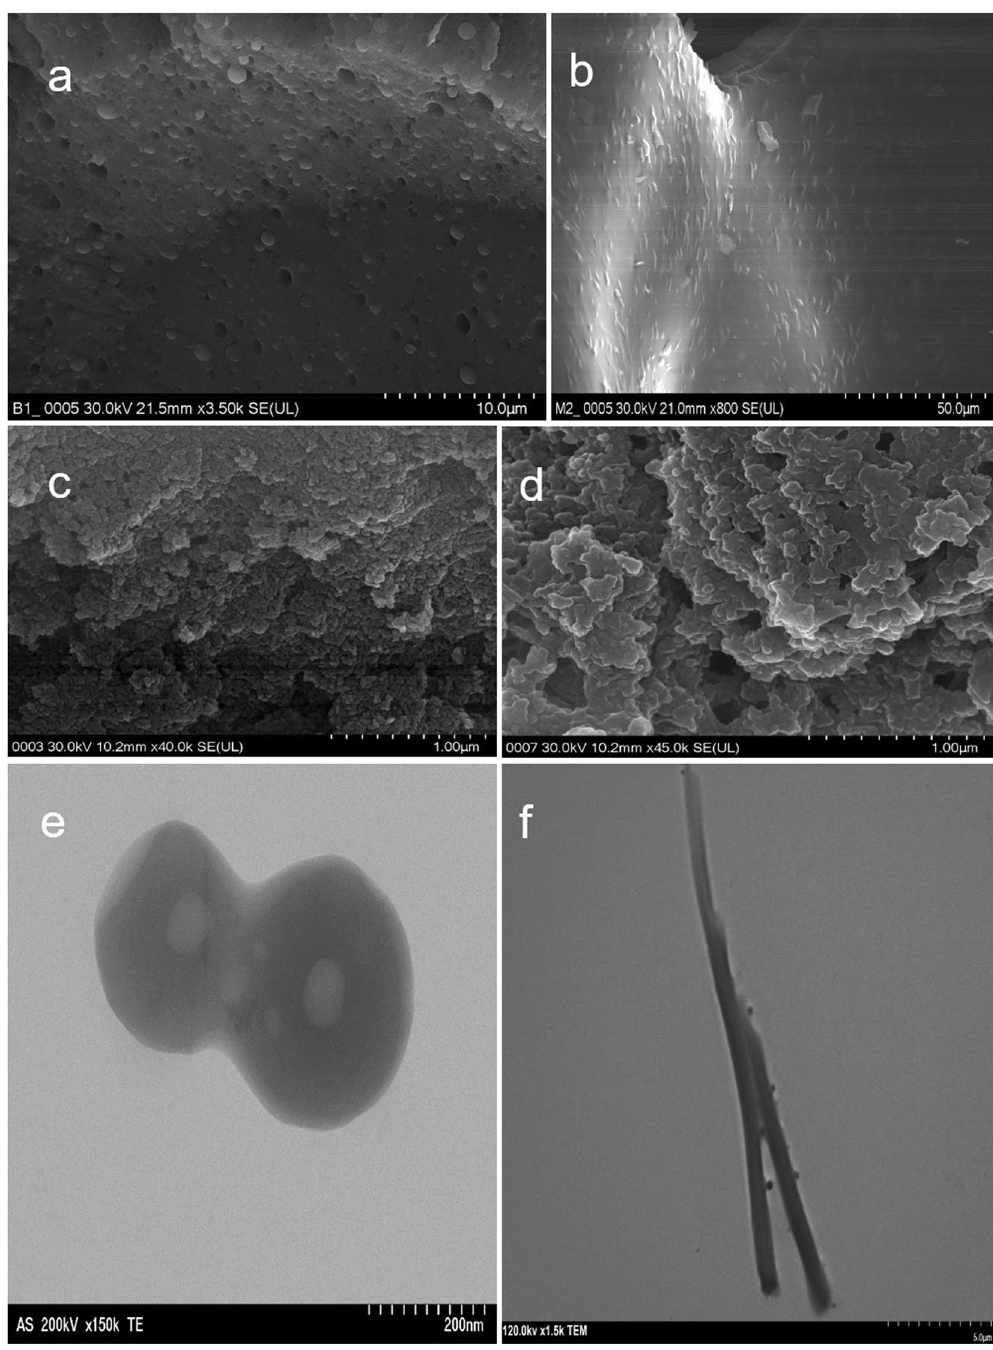
Figure 2. Morphological characters by TEM and SEM micrograph. Images showing the microscopic character of particles found in the demulsified emulsion: ( a ) The bottom layer; ( b – d ) the middle layer; while ( e , f ) the artifacts (emulsion infrastructures). Particles in the bottom layer are in pellet form, which could be useful in their nano dimension as vehicle for drug transport, proteins and immunotoxins target